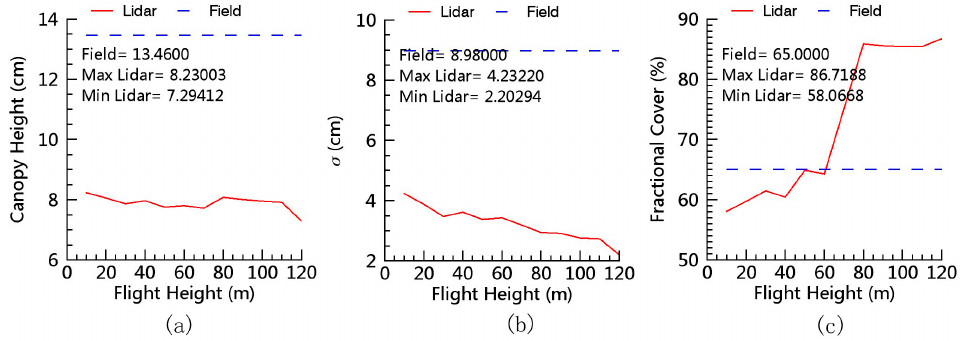
Figure 9. Influence of flight height on lidar-derived mean canopy height ( a ); RMSE of the canopy height ( b ); and fraction canopy cover ( c ). Field/Lidar (cid:2026) : the standard deviation of field measured/lidar-derived canopy